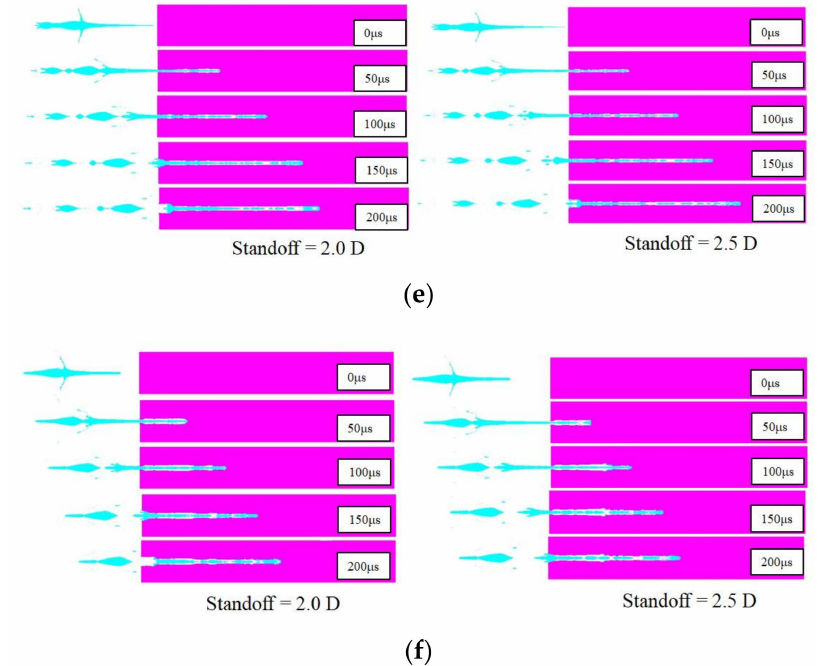
Figure 7. Penetration progresses of shaped charges. ( a ) Penetration progress of shaped charge with nickel cylindrical liner. ( b ) Penetration progress of shaped charge with tungsten cylindrical liner. ( c ) Penetration progress of shaped charge with tantalum cylindrical liner. ( d ) Penetration progress of shaped charge with steel 4340 cylindrical liner. ( e ) Penetration progress of shaped charge with copper cylindrical liner. ( f ) Penetration progress of classical conical-shaped charge.